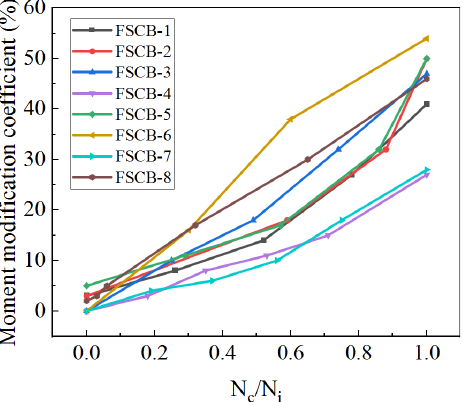
Figure 13. Moment modification coefficient variations.